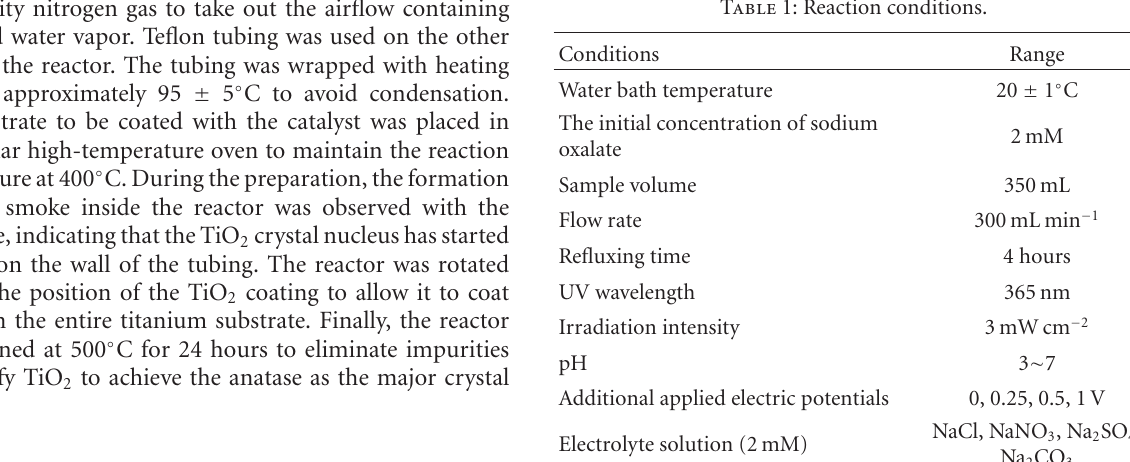
Figure 1: Photoelectrocatalytic apparatus.